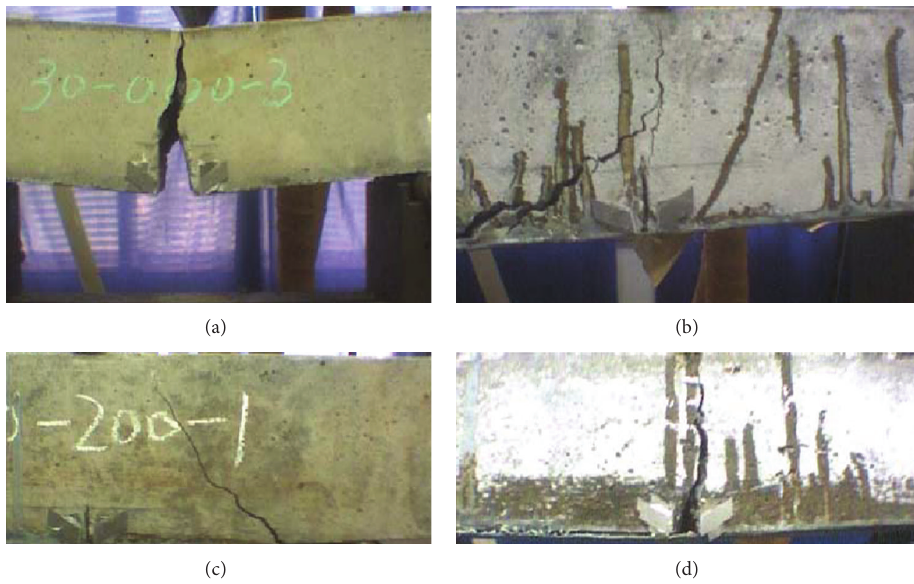
Figure 2: The photos of experimental measurement [11]. (a) Failure mode of the beam without CFRP. (b) Failure mode of the beam with CFRP of 0.1 m. (c) Failure mode of the beam with CFRP of 0.2 m. (d) Failure mode of the beam with CFRP of 0.35 m.